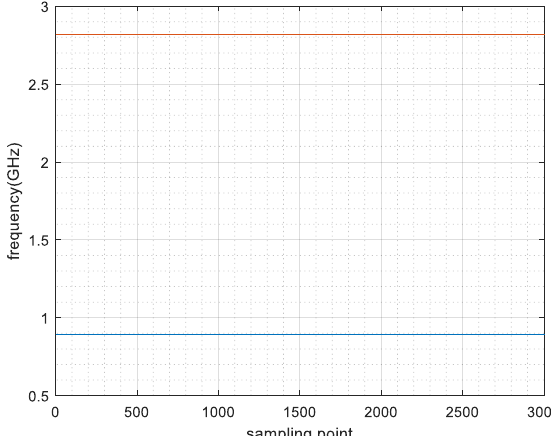
Figure 11. The extracted IF lines.